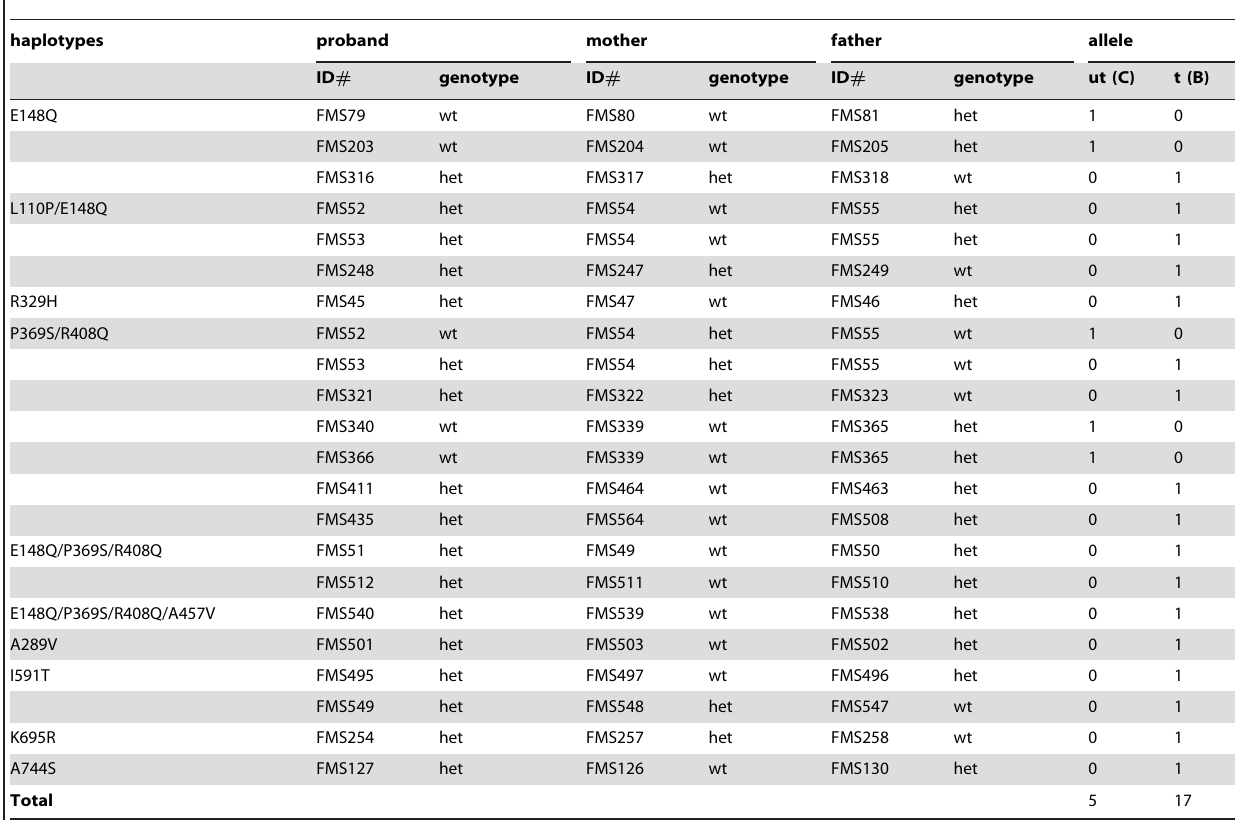
Table 2. Transmission of rare variants for FMS trios. 1,2